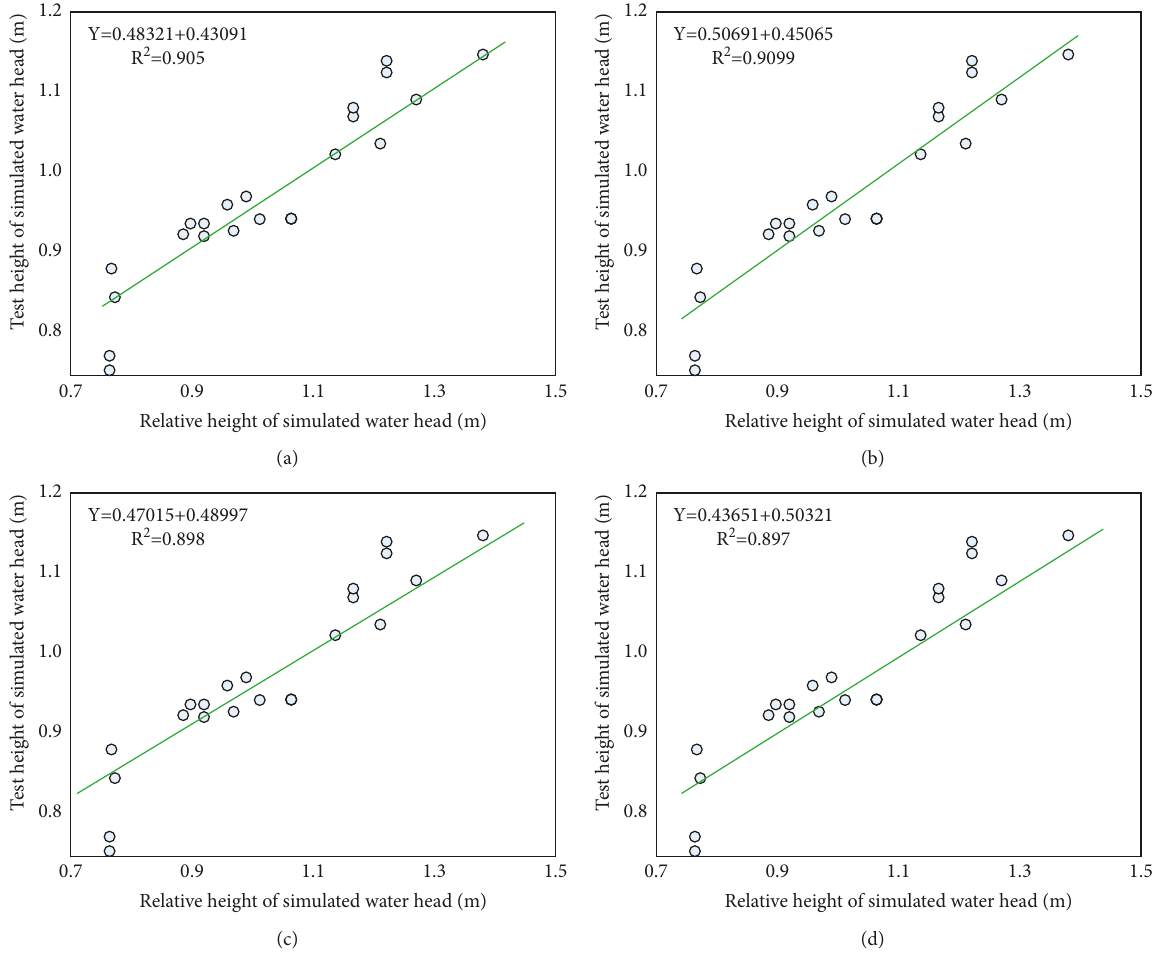
Figure 7: Scatter plot of R 2 analysis with different flow sizes. (a) Q � 0.55m 3 /h. (b) Q � 0.6m 3 /h. (c) Q � 0.65m 3 /h. (d) Q � 0.7m 3 /h.